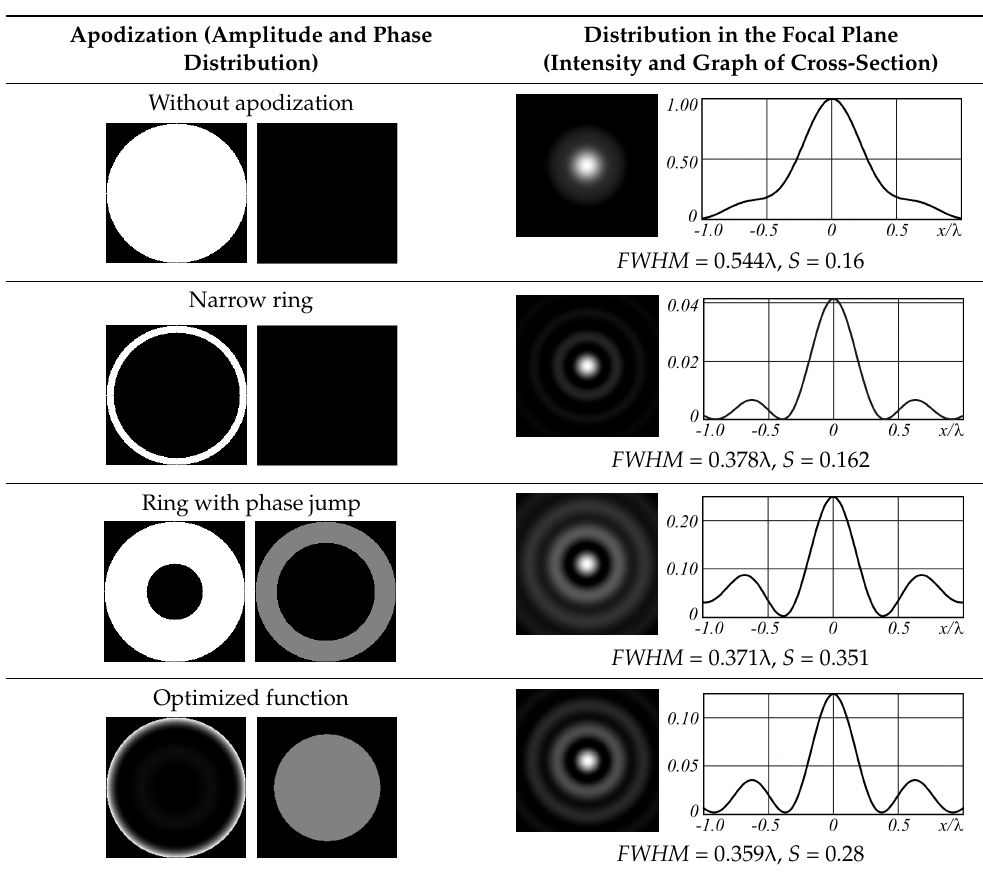
− ( b ) Figure 11. Generation of a compact light spot in the near-field zone by the fractional axicon ( ) ( ) 0 exp r i k r γ   τ = − α   with a) γ = 0.5, 𝛼 (cid:2868) = 125 and b) γ = 0.25, 𝛼 (cid:2868) = 7937607 : graphs show nor- malized intensity sections at distance of z = 0.01 λ (solid line), z = 0.1 λ (dashed line), and z = 2 λ (dotted